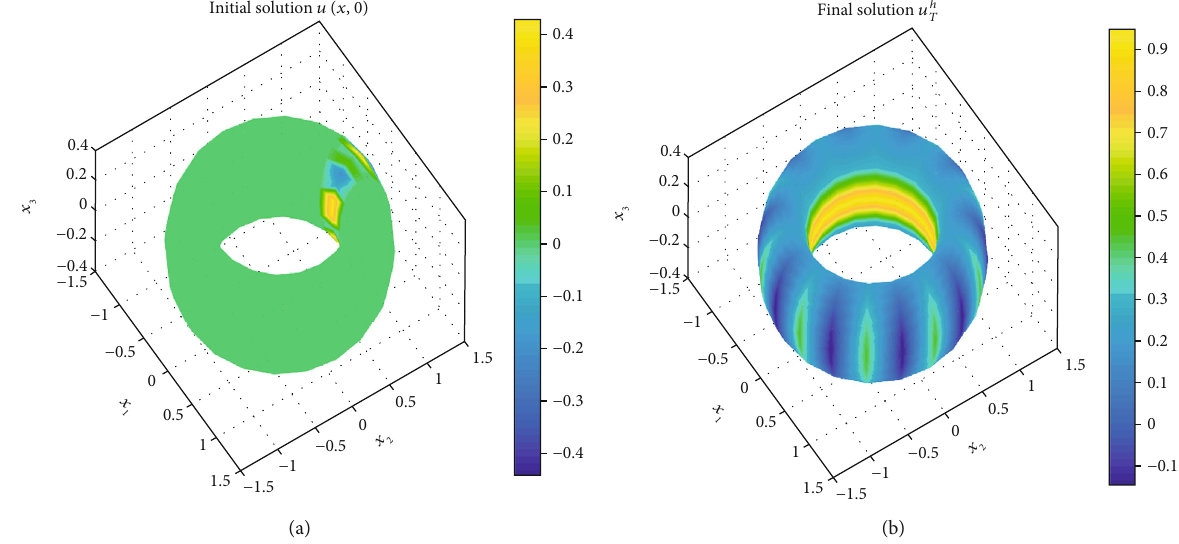
= 2 : 322 × 10 − 3 , D = 0 : 0045 , T = 200 , R = 1 and r = 0 : 3 . v